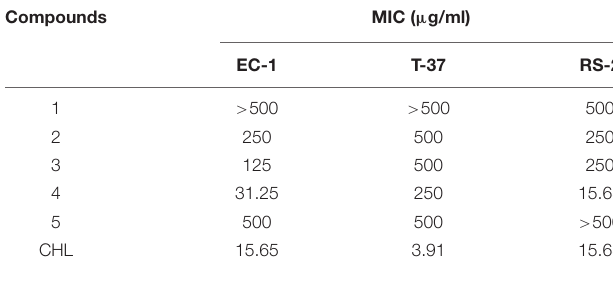
were incubated at 30 ◦ C and shaken with a rotary shaker at 150 rpm. During the culture, six samplings were carried out at 1, 2, 3, 4, 5, and 6 h, and all samples were centrifuged at 8,000 rpm for 3 min and measured the conductivity in the supernatant.